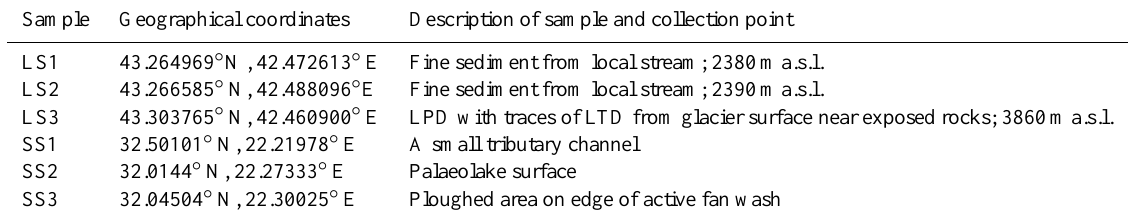
Table 1. Details of the control samples from Mt. Elbrus (LS) and El Mechili region in north-eastern Libya (SS). Sample Geographical coordinates Description of sample and collection